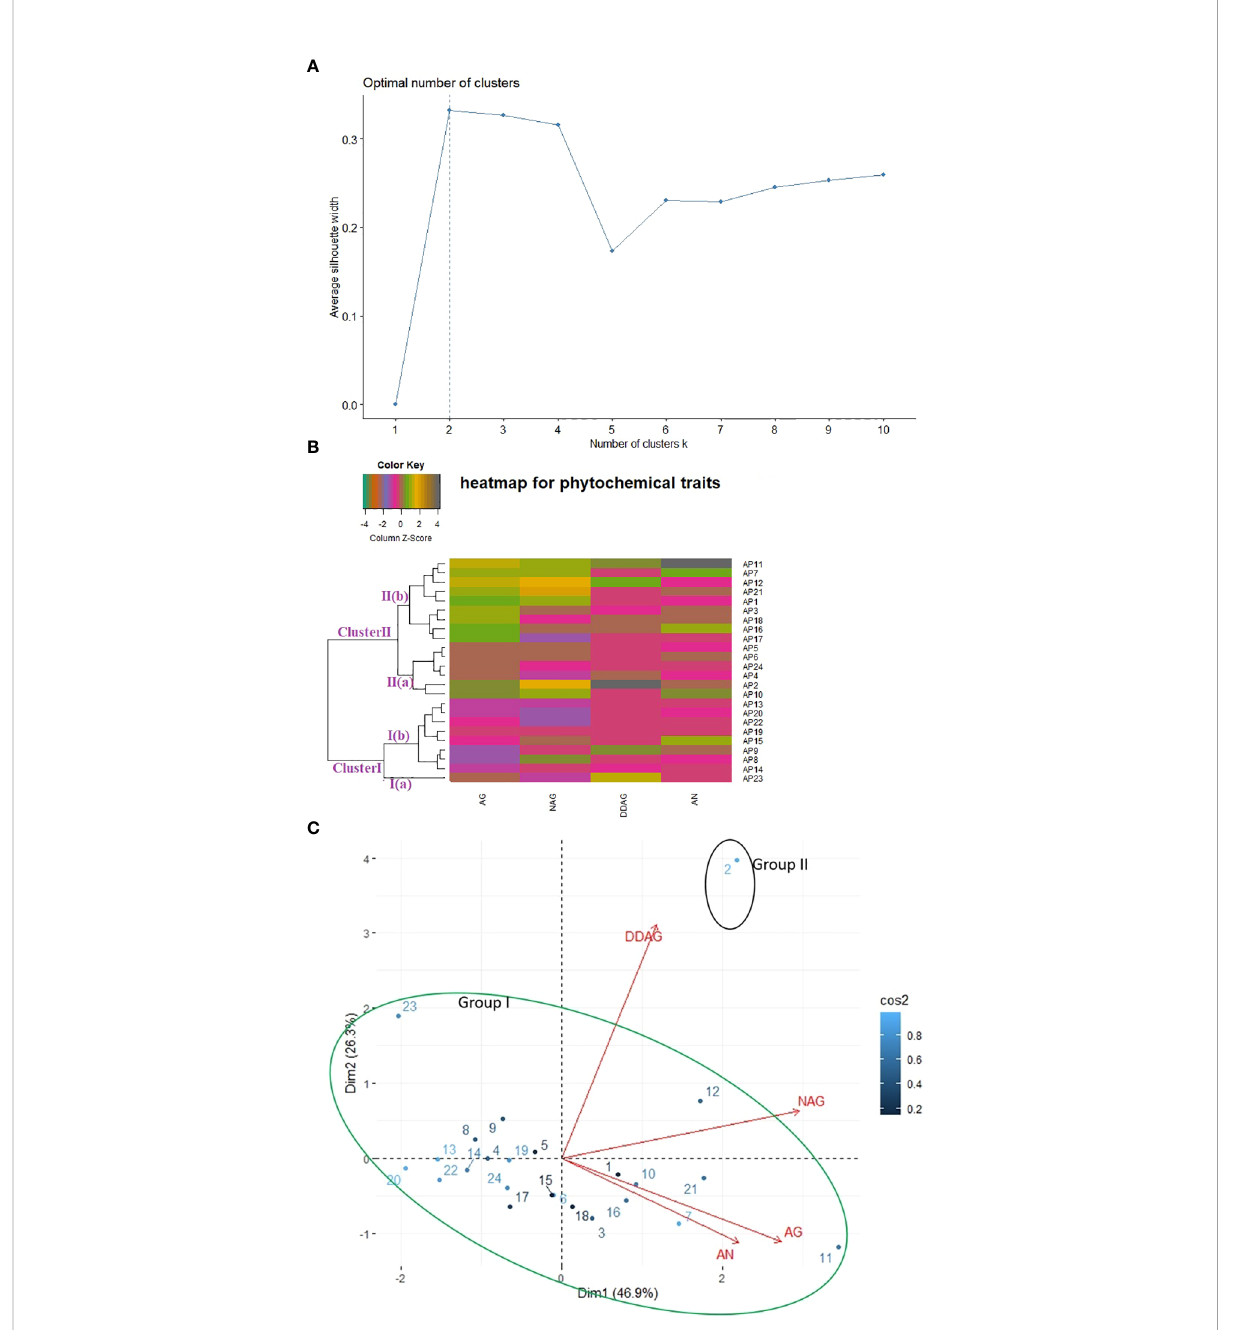
FIGURE 4 Relationship among twenty-four accessions of kalmegh based on phytochemical traits using (A) k-mean (B) Euclidean distance (C) PCA